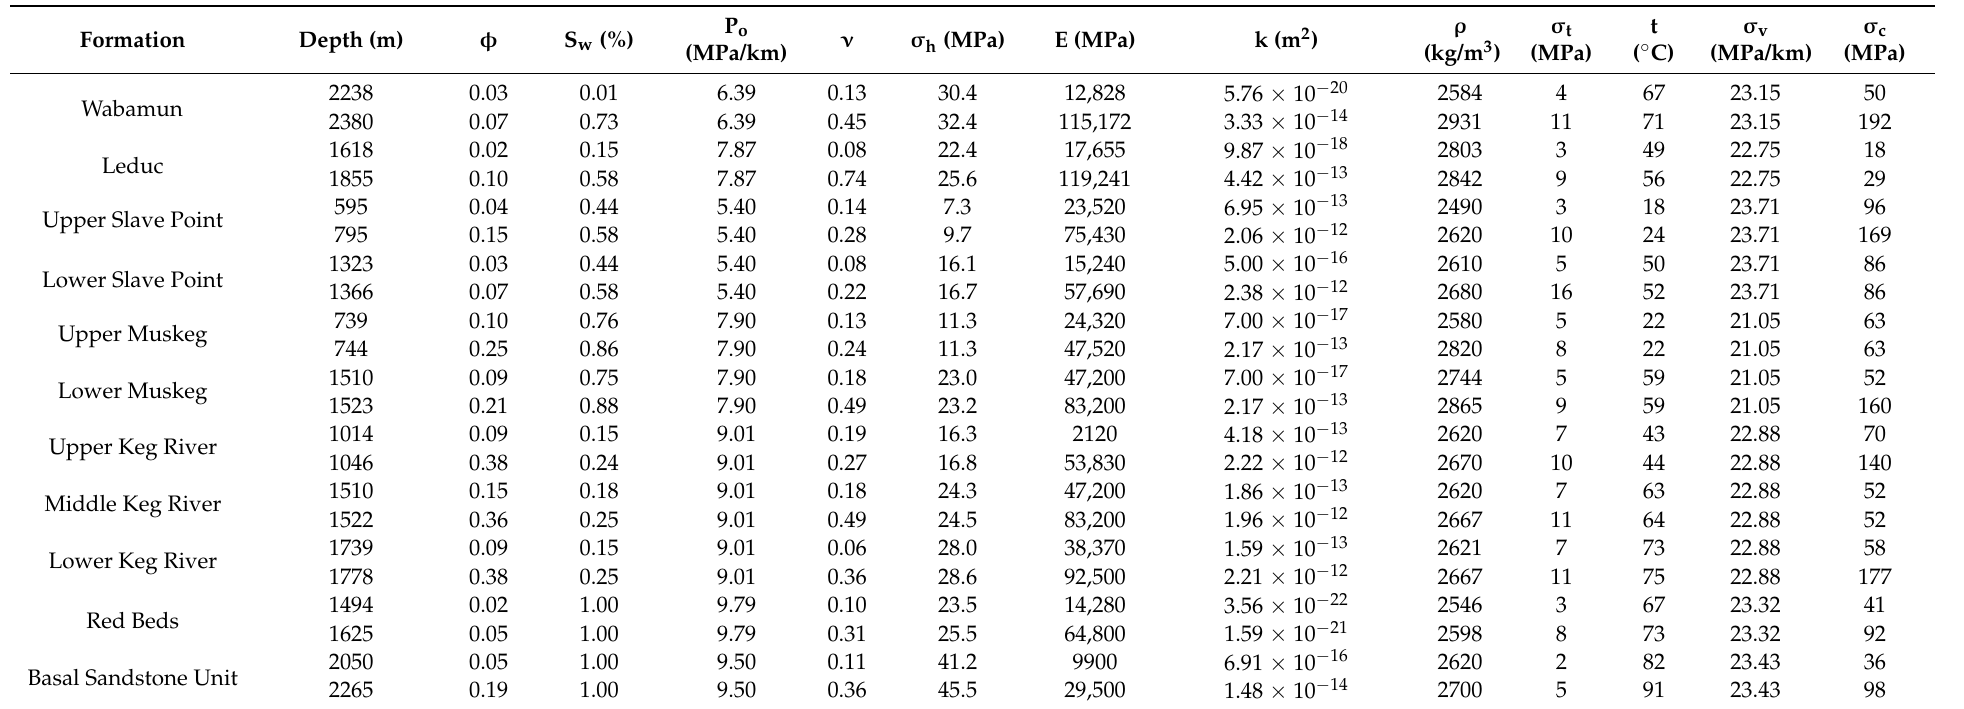
Table header key: φ : total porosity; S w : water saturation; P o : pore pressure gradient; ν : Poisson’s ratio; σ h : minimum horizontal stress: E: Young’s modulus; k: permeability; ρ : bulk density;